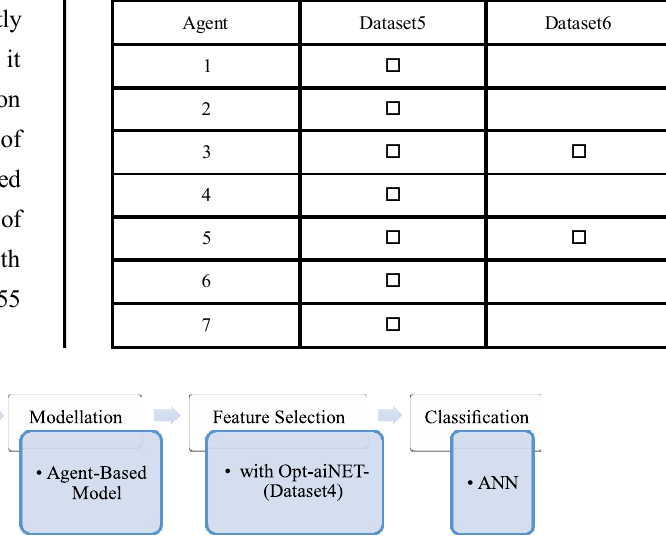
TABLE 5. SELECTED AGENTS FOR DATASET3 AND DATASET4